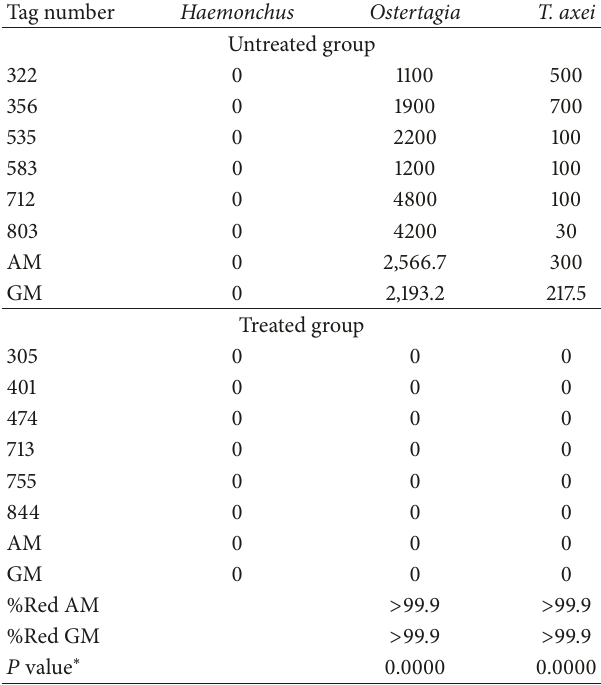
Table 2: Abomasal worm burdens from weaner mixed sex red deer individually identified into untreated and treated groups. The latter group was dosed per os with Exodus Pour-On Oxfen C Plus 50/50 mixture at 1ml/5 kg bodyweight 11 days prior to